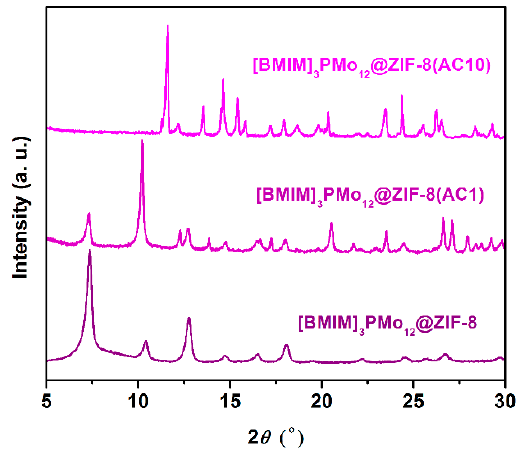
Figure 4. Reutilization performance of [BMIM] 3 PMo 12 @ZIF-8 over 10 cycles combining desulfuriza- tion and denitrogenation processes to treat a multicomponent model fuel (BT, DBT, MDBT, DMDBT, IND, QUI), using [BMIM]PF 6 as extraction solvent and H 2 O 2 as oxidant.